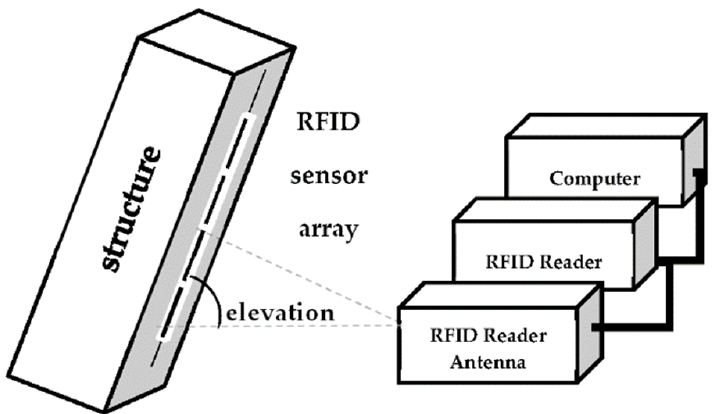
Figure 6. Test platform for motion detection.